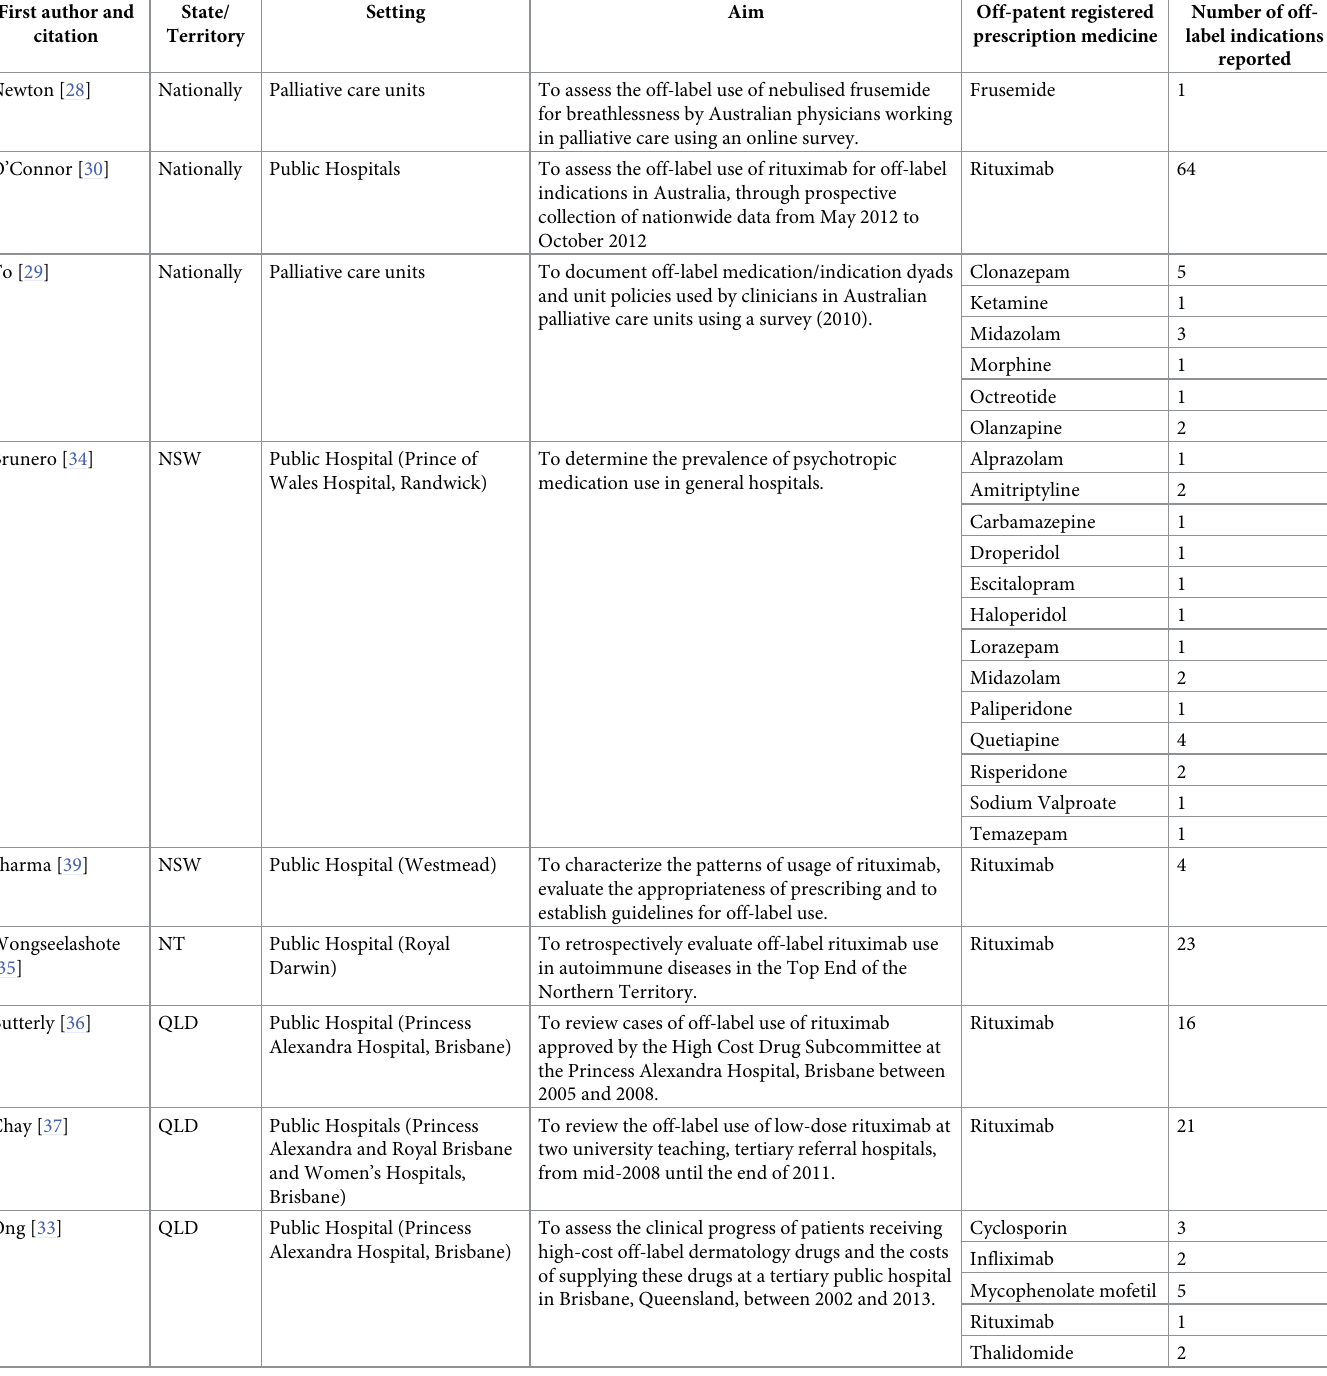
Table 4. Evidence from the literature of off-patent registered prescription medicines used for off-label indications in